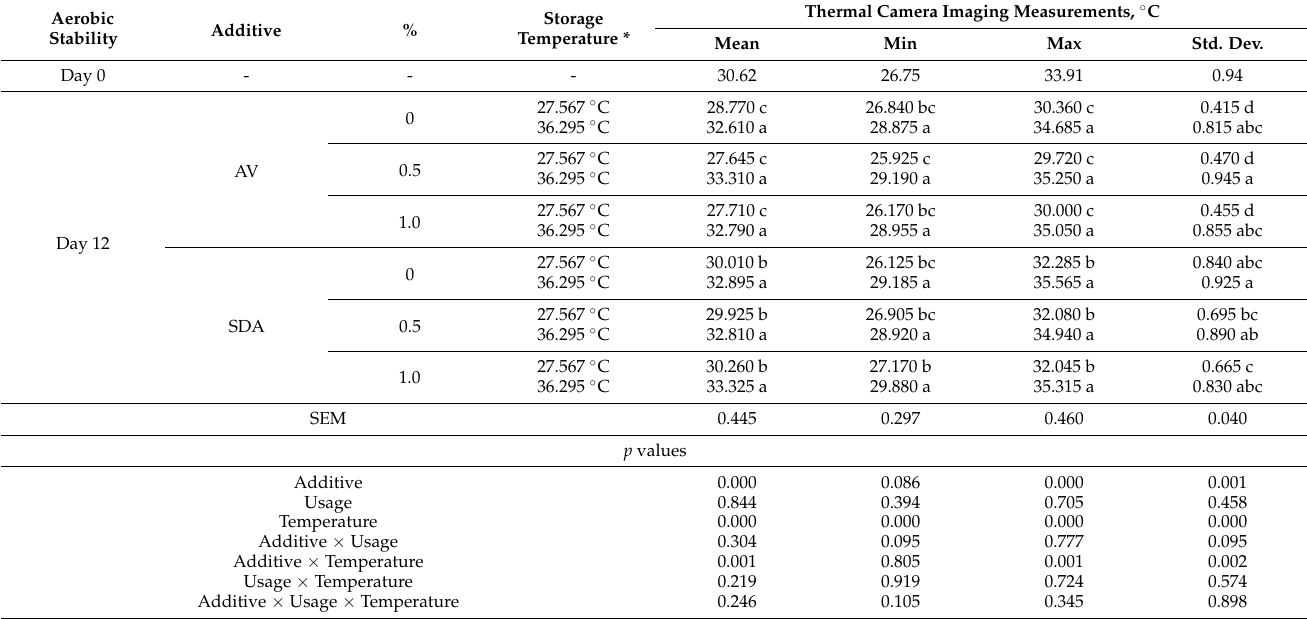
Table 9. Thermal camera imaging results of aerobic stability on day 12 (Ambient temperature = 22 ◦